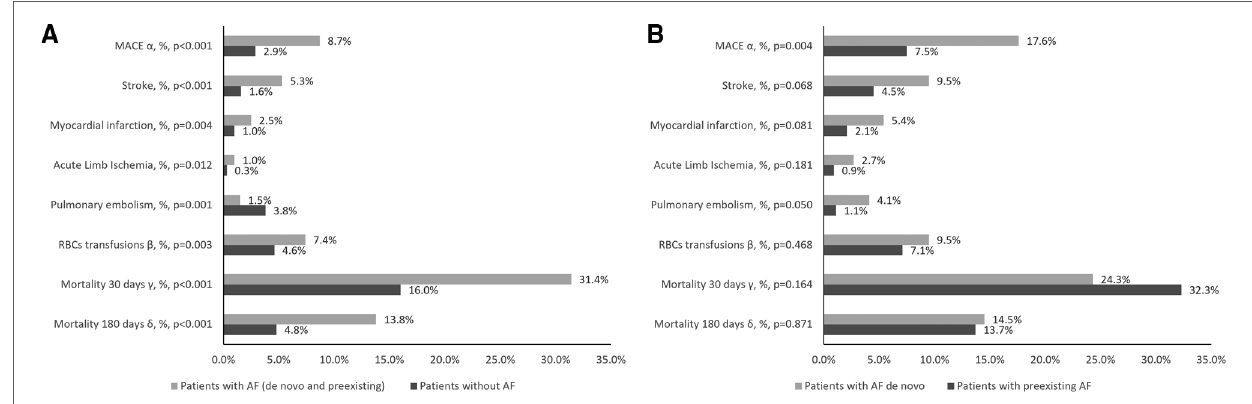
FIGURE 1 Outcomes among patients without AF and with AF ( A ) and among patients with pre-existing AF and with AF de novo ( B ). Data are presented as %. p <0.01 for between AF group and No AF group difference; α – MACE, major adverse cardiovascular events including any incident stroke, myocardial infarction or acute peripheral artery ischemia; β - need for red blood cells transfusion was used as a surrogate for major bleeding events; γ - death from any cause in 30-days follow up since hospital admission; δ - death from any cause in 180-days follow up after hospital discharge; (analysis for patients discharged alive